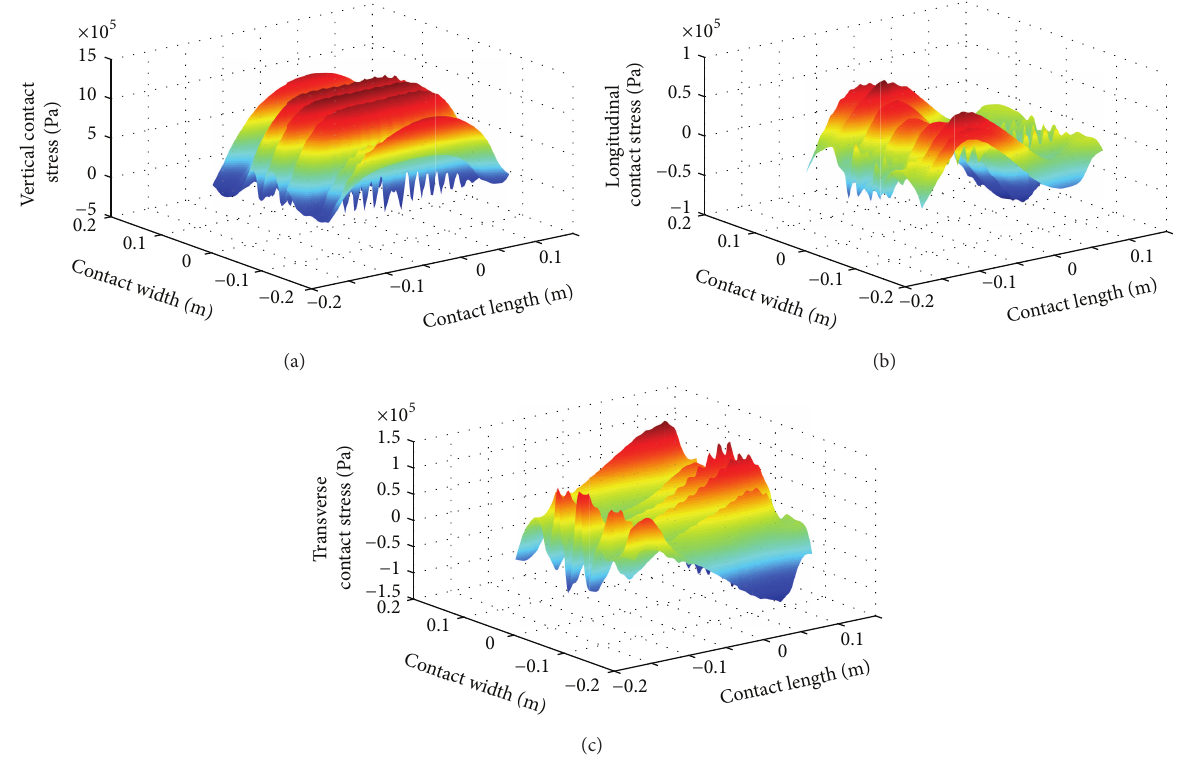
Figure 13: Contact stress distribution under steady free